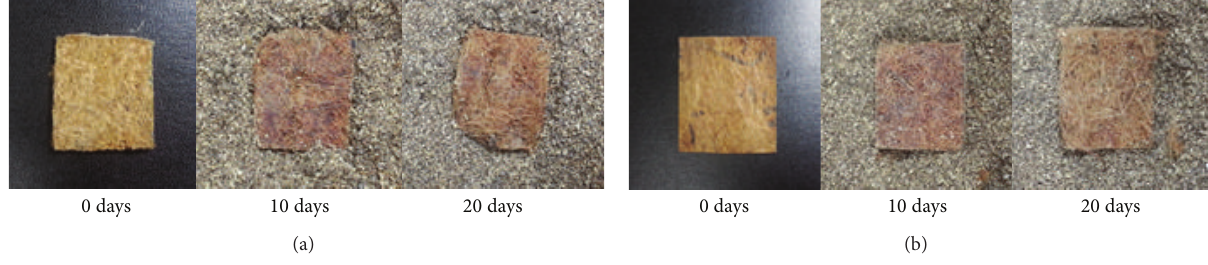
Figure 19: Photographs of the kenaf/SPI-PVA composite with compost time: (a) kenaf/SPI-PVA composites without GA, (b) kenaf/SPI-PVA composites with